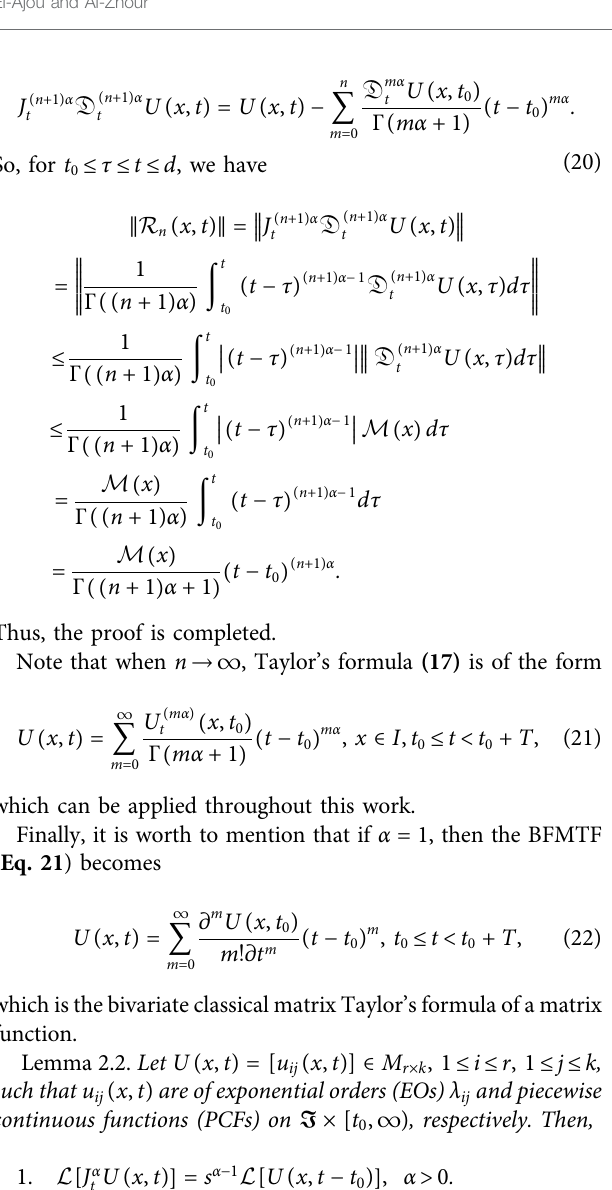
( x , t )|| for different values of α . 6